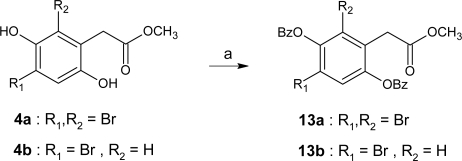
Synthesis of 13a and 13b.Reagents and conditions: (a) benzoyl chloride, trimethylamine, CH2Cl2, 1 h, 0 °C, 70%.